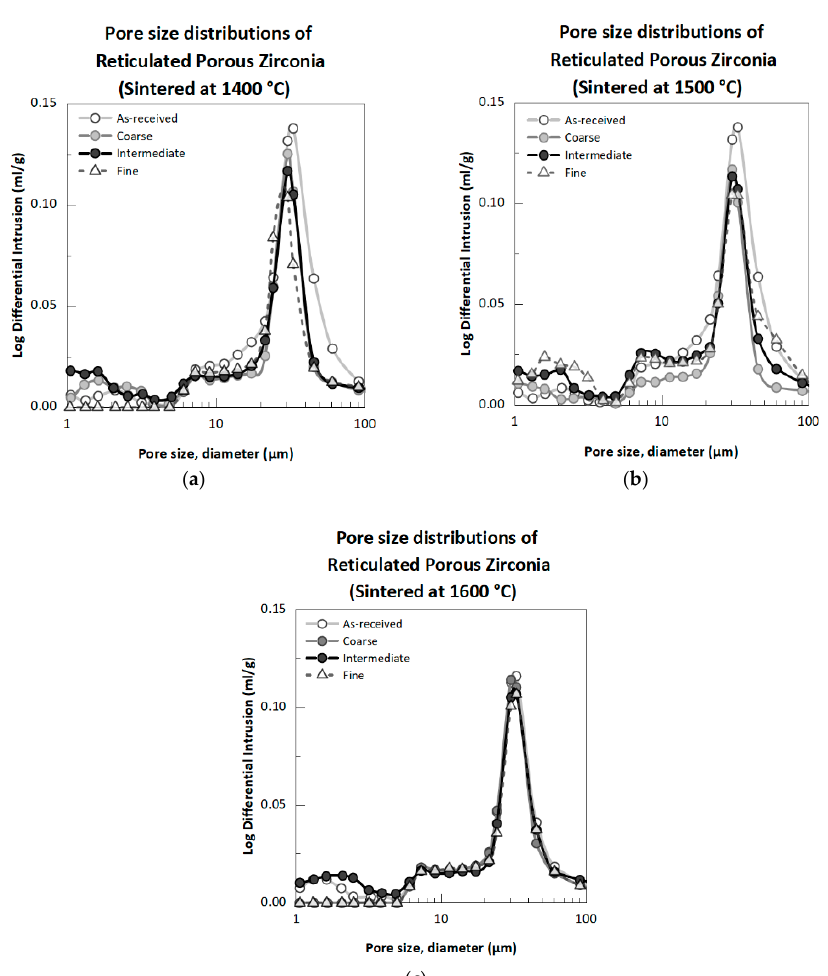
Figure 12. Pore size distributions of the reticulated porous zirconia prepared from the as-received, coarse, intermediate, and fine zirconia particles when sintered at ( a ) 1400 °C, ( b ) 1500 °C, and ( c ) coarse, intermediate, and fine zirconia particles when sintered at ( a ) 1400 ◦ C, ( b ) 1500 ◦ C, and ( c ) 1600 °C . 1600 ◦